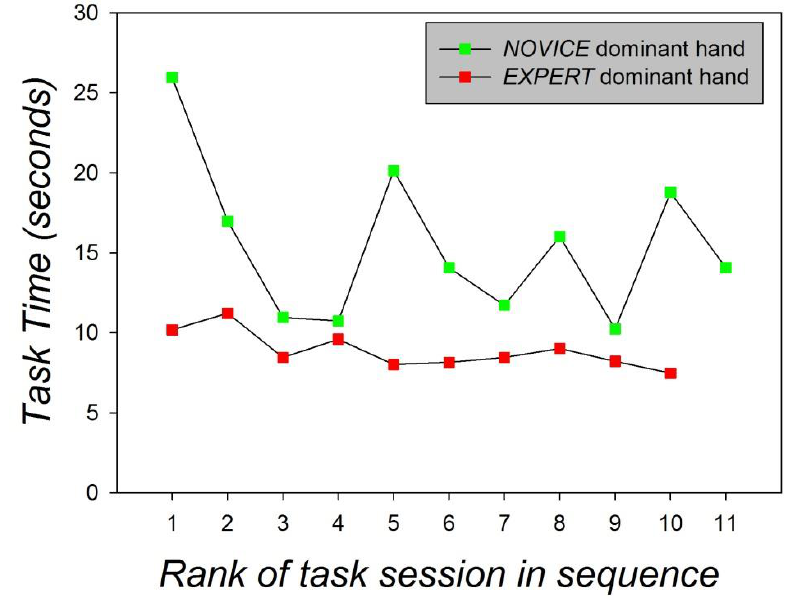
Figure 11. Task times from the sessions of the expert and the novice performing the task on the robotic system with their dominant hands.